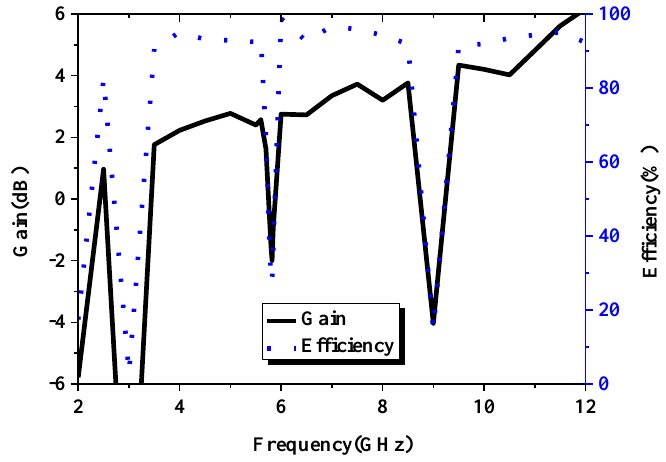
Figure 6. Surface current distribution of the proposed antenna with junction capacitance of 0.63 pF: ( a ) 5.67 GHz and ( b ) 9.29 GHz.